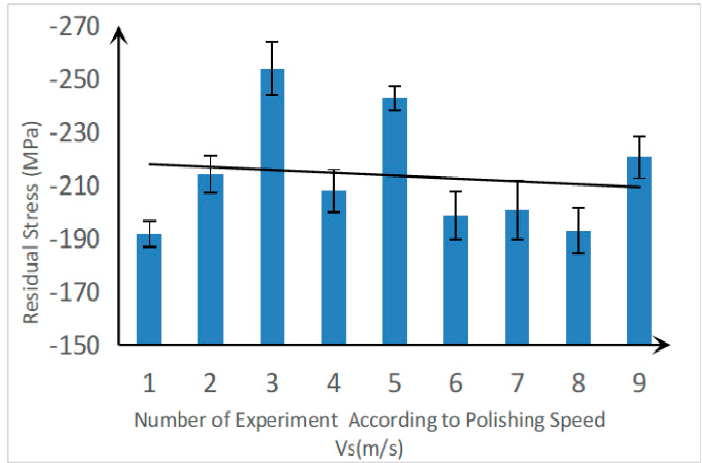
Figure 14. Relationship between the surface residual stress and the belt line speed.